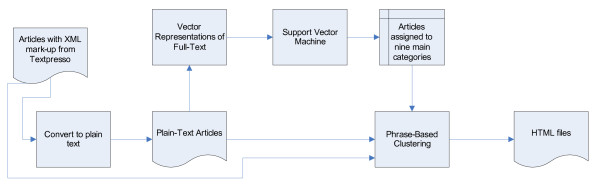
Overview of the classification process. Full-text papers are taken from the Textpresso corpus and processed via SVM and phrase-base clustering. The end result is a large set of html files displaying the paper taxonomy.